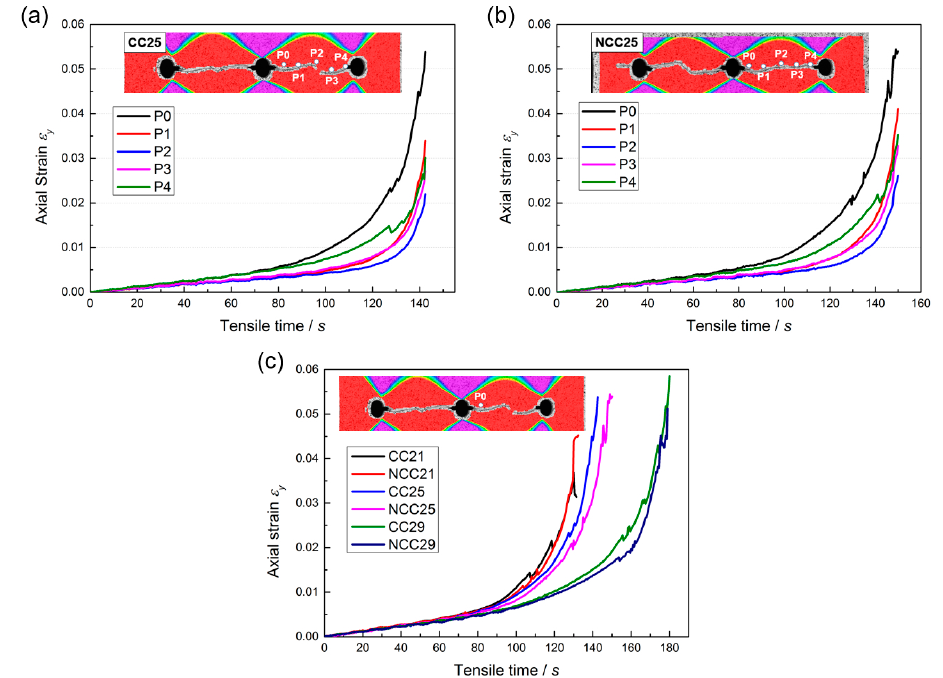
Figure 5. Axial strain and tensile time evolution curve of ( a ) CC25, ( b ) NCC25, and ( c ) the points P0 in six types of specimen. The maximum ε y was always distributed around the cracks. At P0, failure occurred first for CC25 and NCC25; the points of NCC25 spent more time in failure than those of CC25 respectively. For six samples, the tendencies are consistent.